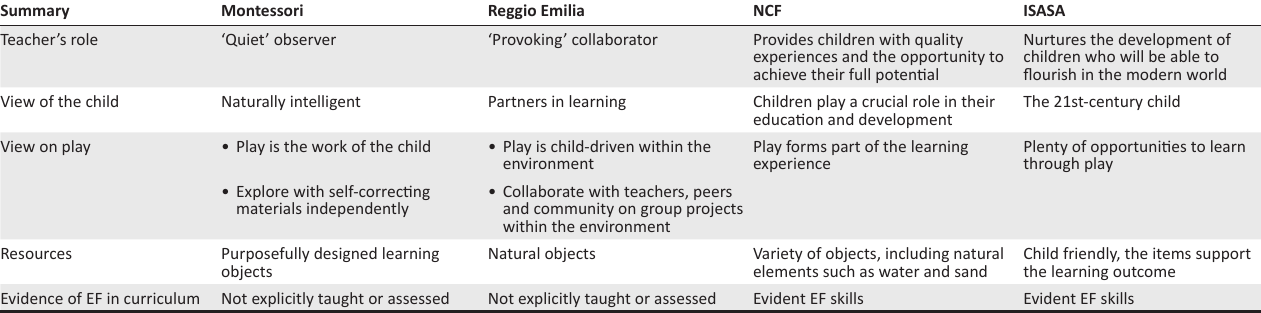
TABLE 1: A comparative overview of the curricula/approaches applied in the